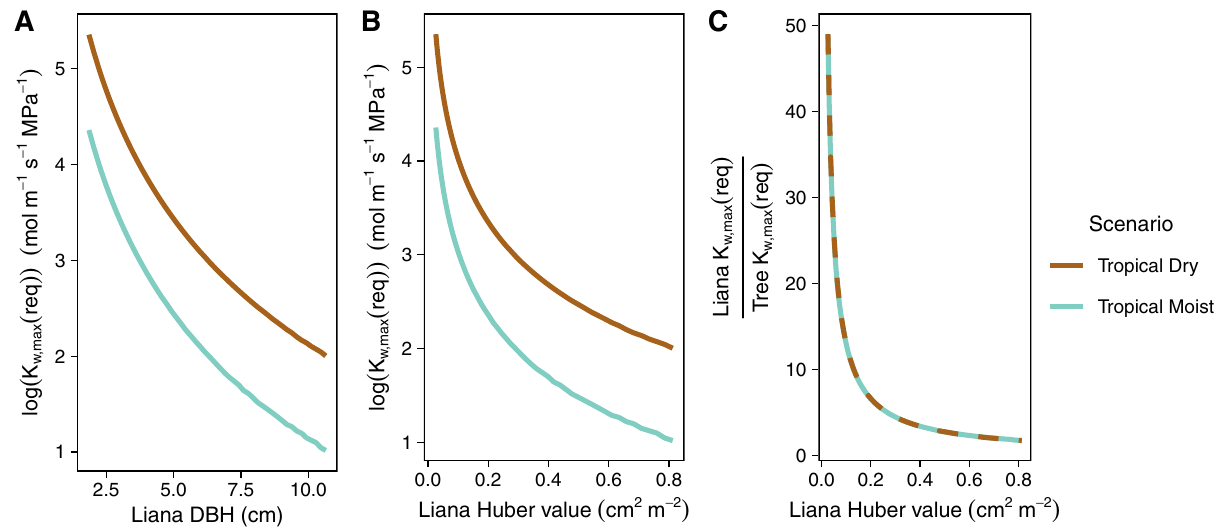
Fig. 2 Allometry and climate affect required maximum whole-plant hydraulic conductivity. Required maximum whole-plant hydraulic conductivity (K w,max (req)) as a function of diameter at breast height (DBH, A ) and Huber value (sapwood area [cm 2 ] per unit leaf area [m 2 ]), B , C and hydroclimate (tropical moist forest or tropical dry forest). Total leaf area = 200 m 2 , 60% tree leaf area, 40% liana leaf area. In all three panels, colors represent the different hydroclimate scenarios (tropical dry forest = brown; tropical moist forest = blue). A Liana log(K w,max (req)) as a function of liana DBH. B Liana log(K w,max (req)) as a function of liana Huber value. C The ratio of liana K w,max (req) to tree K w,max (req) as a function of liana Huber value. Tree K w,max (req) was computed at a reference scenario where tree DBH = 18.2